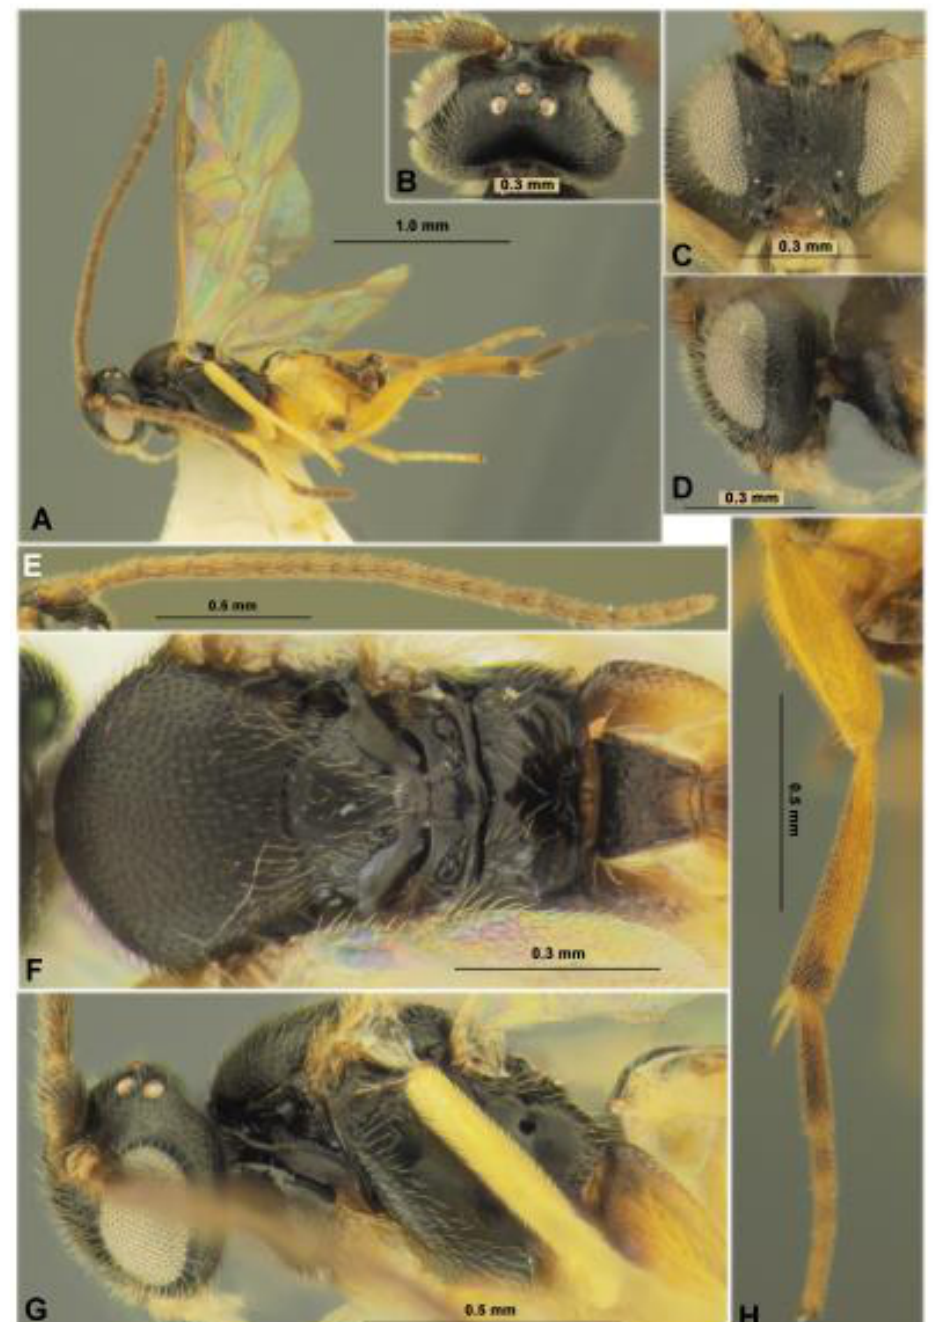
Figure 11. Microgastrinae: Pholetesor nataliae sp. nov. (holotype, female). Habitus in lateral view ( A ), head in dorsal ( B ), frontal ( C ) and lateral ( D ) views, antenna ( E ), mesosoma in dorsal view ( F ), mesosoma in lateral view ( G ), hind leg ( H ).